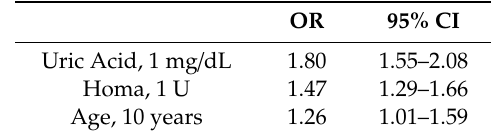
Table 5. Logistic regression analysis on vascular damage (PWV > 10 m / s).